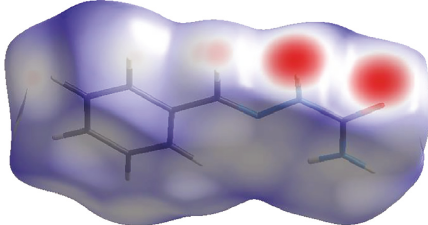
Figure 6: Hirshfeld surfaces mapped with d